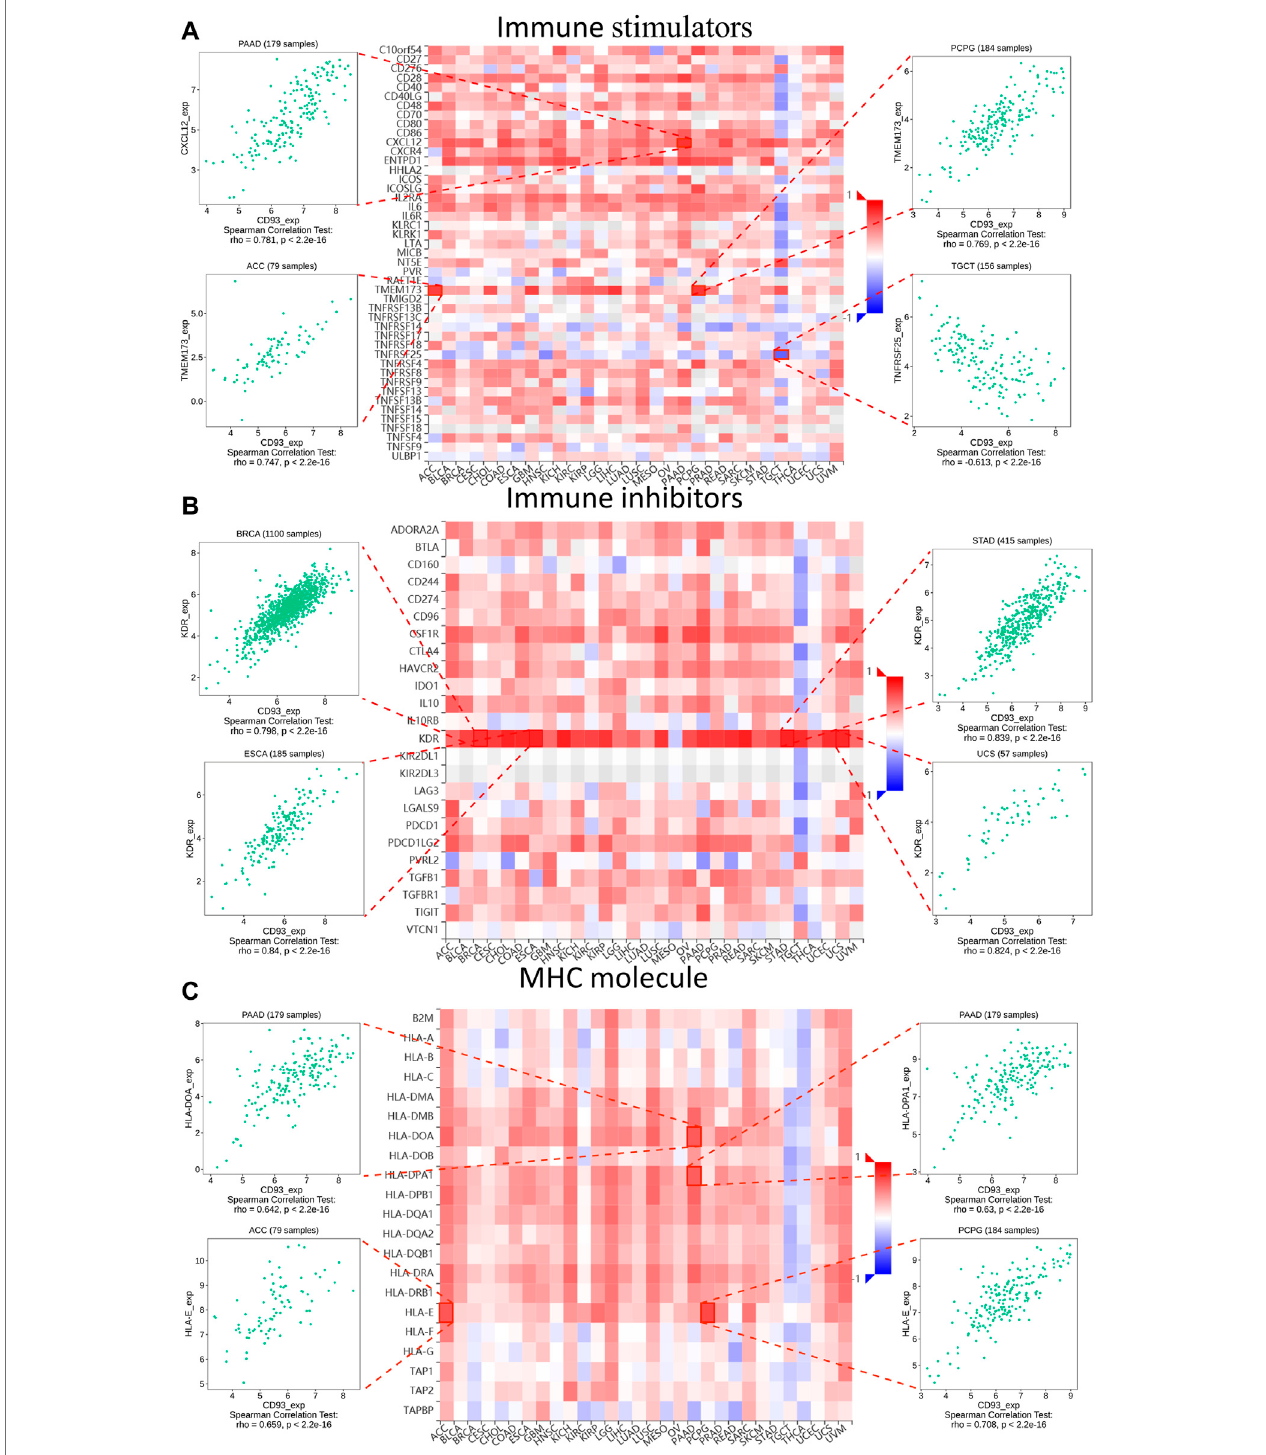
FIGURE 5 | Relationship between three kinds of immunomodulators and CD93 expression according to the Tumor – Immune System Interactions and Drug Bank (TISIDB) database.ExpressioncorrelationsbetweenCD93andimmunestimulators (A) ,immuneinhibitors (B) ,andMHCmolecules (C) . Red and blue represent positive and negative correlations, respectively. The four immune genes most strongly associated with CD93 expression are shown in the dot plot.